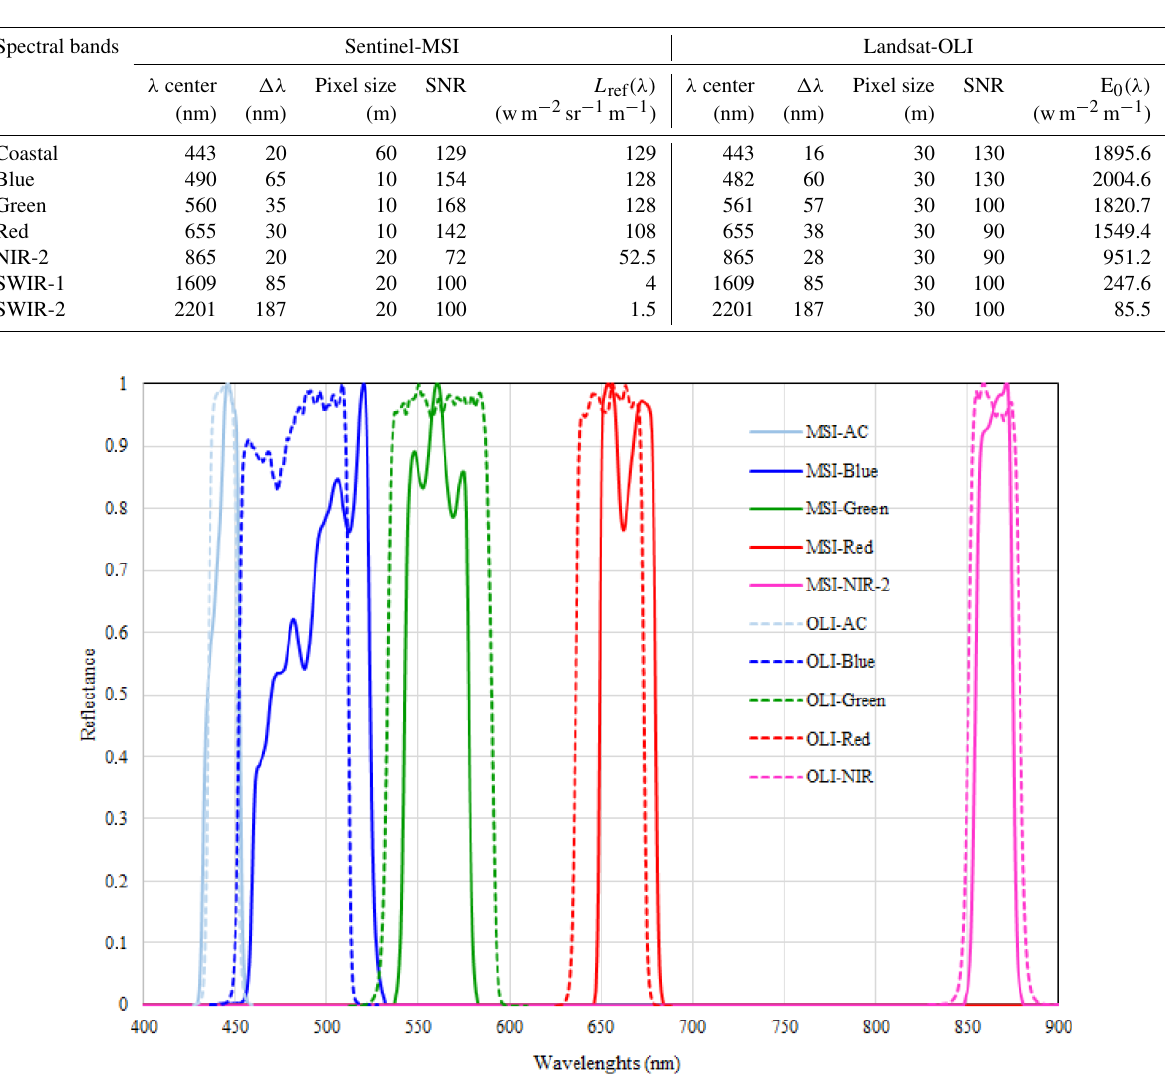
Figure 6. Sentinel-MSI and Landsat-OLI relative spectral response profiles characterizing the filters of each spectral band in the